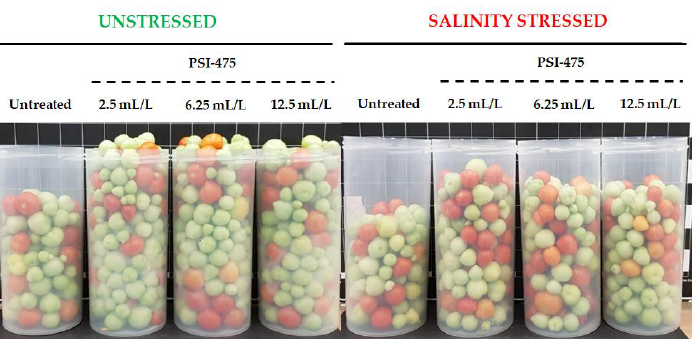
Figure 2. Effect of salinity and PSI-475 dosage rate on tomato fruit number and yield. Fruits shown in the pictures were harvested from 11 plants per treatment and condition.